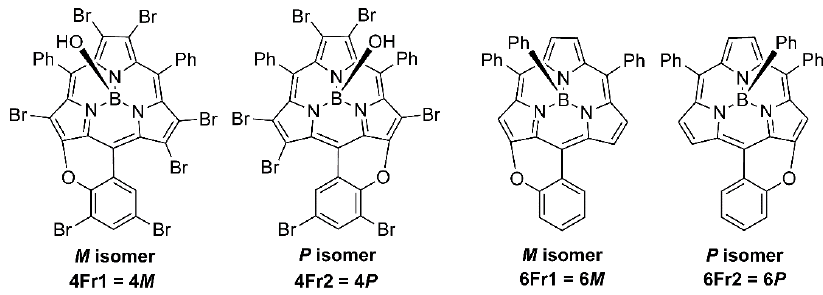
Molecules 2021 , 26 , 1140 Figure 5. Enantiomers of 4 and 6 . Table 2. Transition dipole moments and chiroptical properties of 4’ P , 6’ P , and 6’ P -90 calculated by the TDDFT method at the B3LYP/6-311G(d,p) level. The dihedral angles of the meso -phenyl substituents from the subporphyrin core (θ1 and θ2) are shown below.